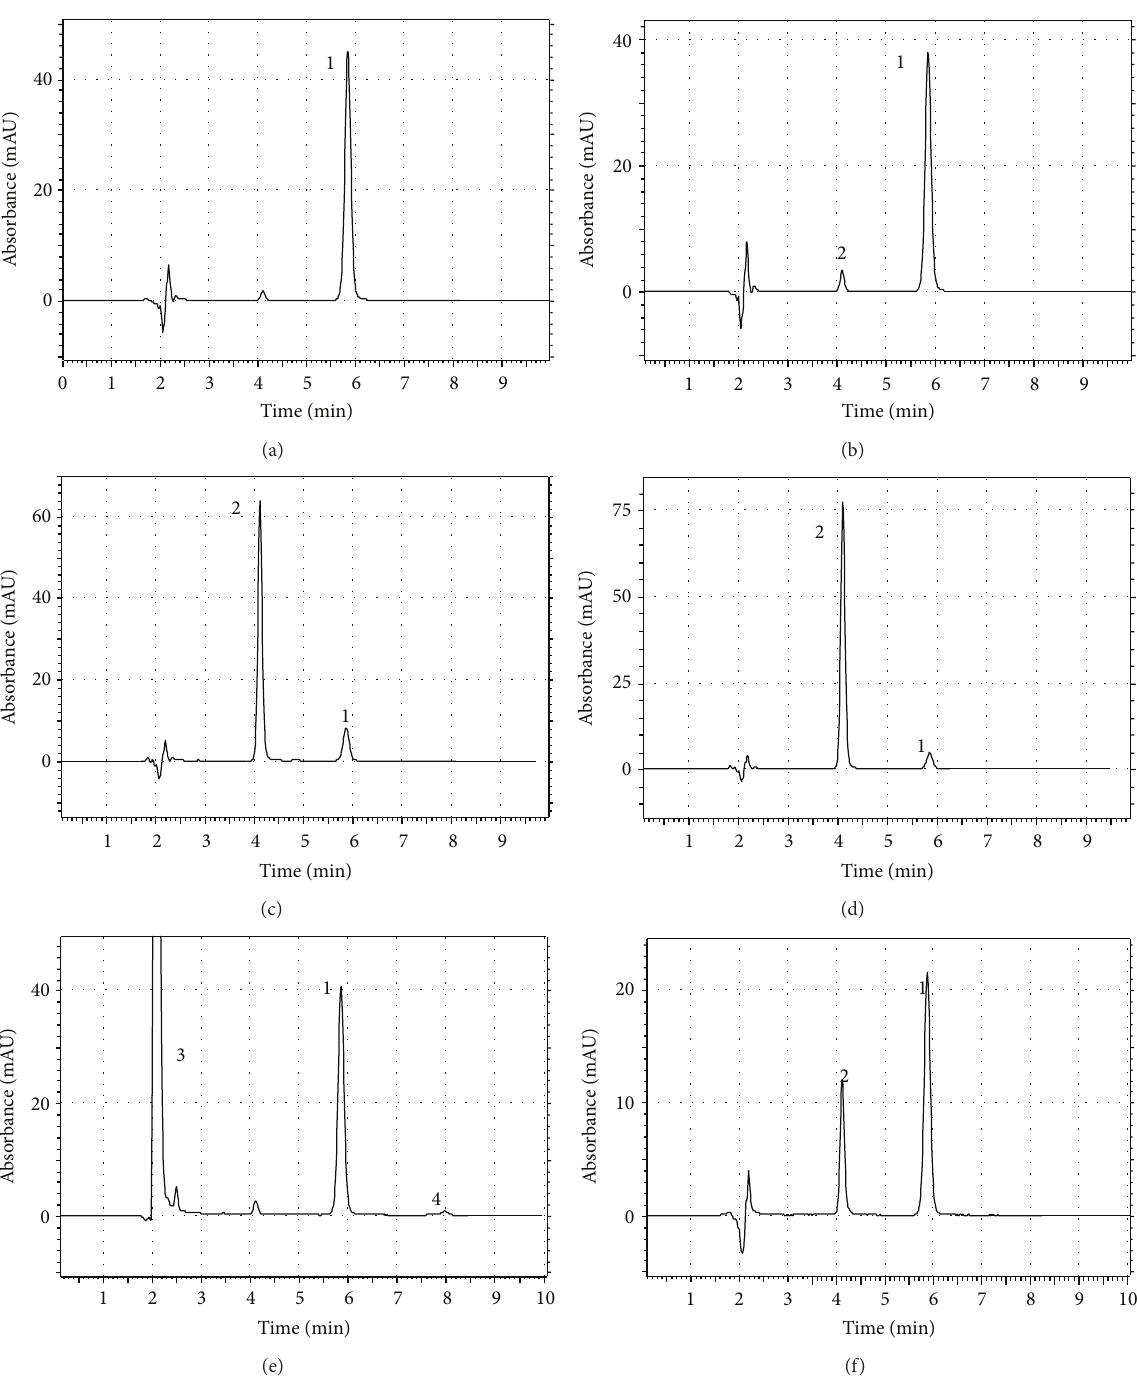
RSD values calculated for the analysis of three diltiazem con- centration levels of 5, 10, and 50 𝜇 g/mL are shown in Table 2; the mean values were found to be 100.1%, 99.06%, and 98.78% with RSDs 1.32%, 0.67%, and 0.59%, respectively, demonstrat- ing that the method is accurate within the desired